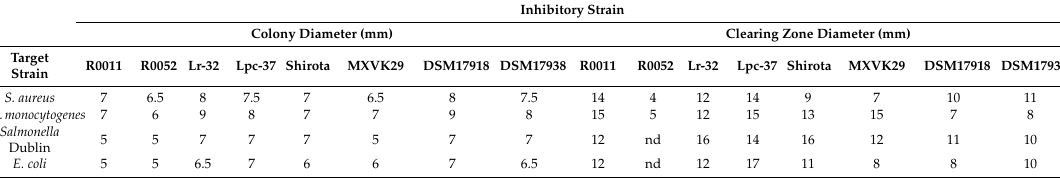
Table 3. Antimicrobial activity of probiotic strains against pathogens associated with fermented